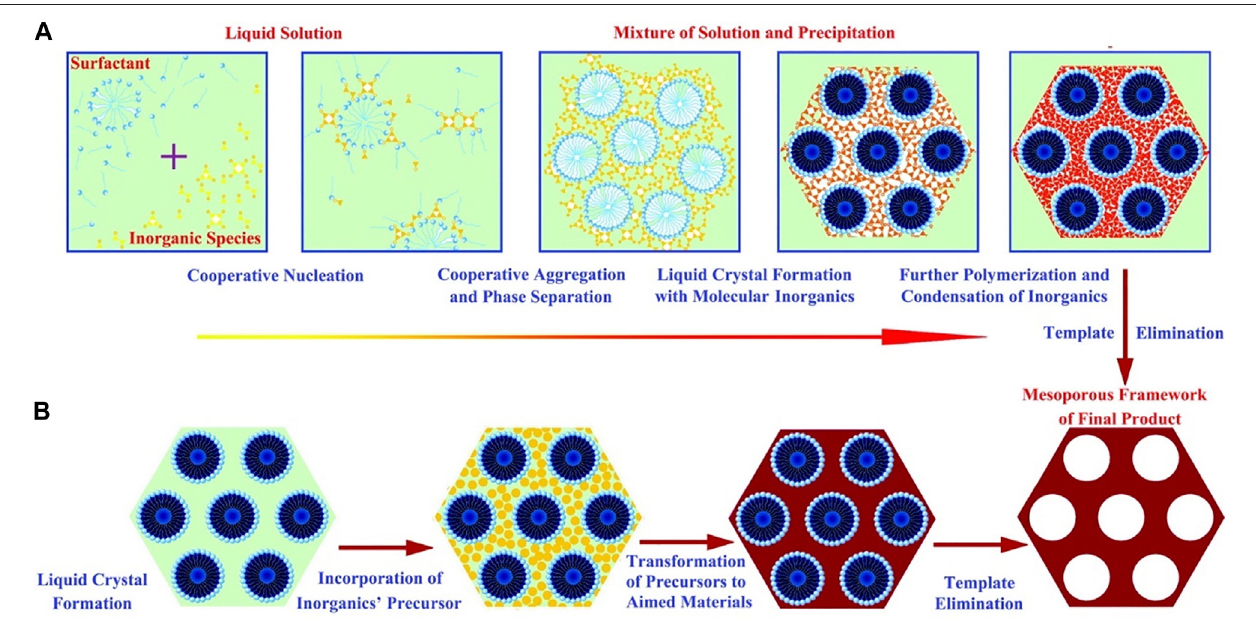
FIGURE 5 | Mechanism of the soft template method (Wan and Zhao,